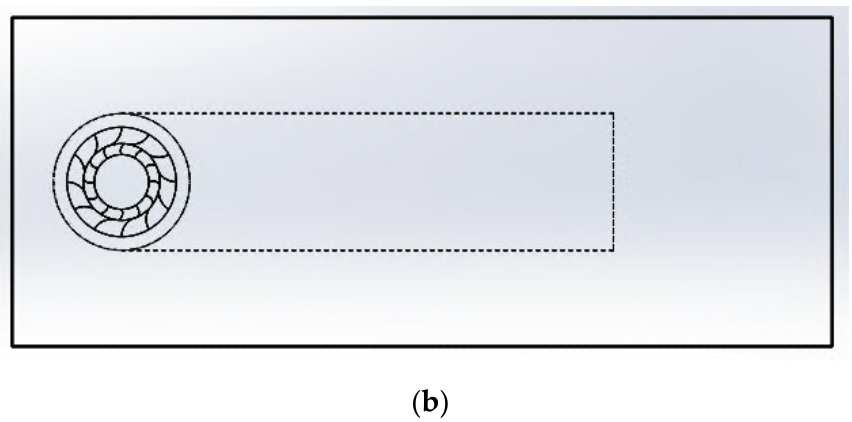
Figure 2. Geometry of the flow domain. ( a ) Drawing of the flow domain sections; ( b ) complete flow domain.